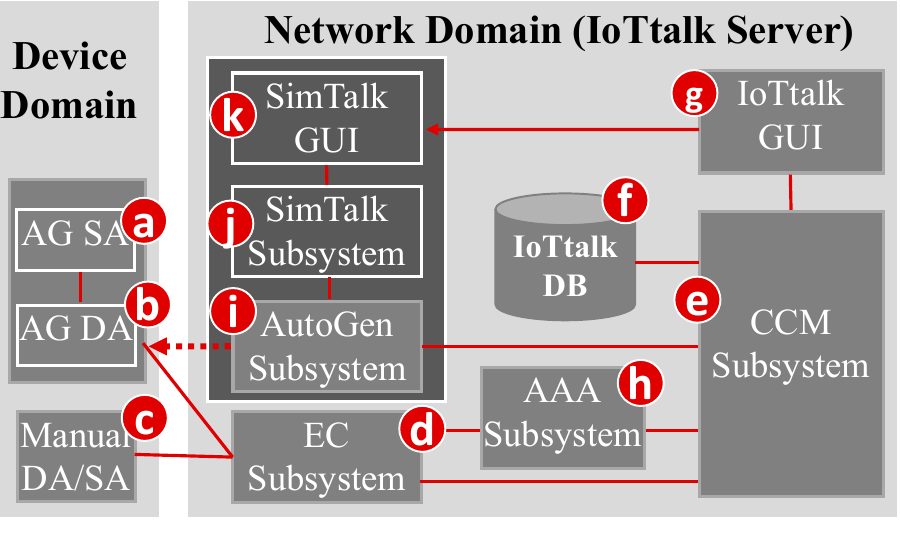
Figure 1. The IoTtalk architecture.